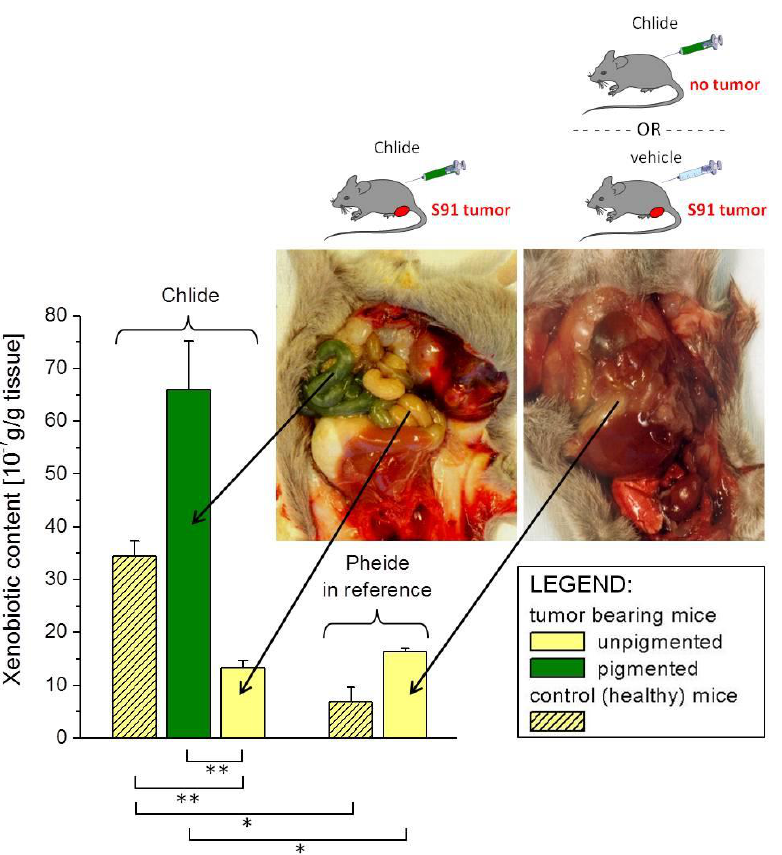
Figure 5. The levels of Chla derivatives in the intestines of DBA/2 mice: The test of Chlide content in the intestines of tumor-bearing and healthy control mice was performed 0.5 h after its i.p. administration. The levels of Pheide in reference mice (no compound administered) was also examined. The photographs in the inset were taken 0.5 h after Chlide was administered into the tumor-bearing mice (right) and the control mice (left). The bars represent the mean ( ± SE) level of Chlide in the intestine estimated via extraction with organic solvent. Chlide: three independent experiments, the number of animals N = 10; the reference: two independent experiments, N = 4. Statistical significance of the differences between groups: 1—** pigmented intestine vs. unpigmented intestine in tumor-bearing mice: p < 0.01; 2—** intestine in healthy mice treated with Chlide vs. unpigmented intestine in tumor-bearing mice treated with Chlide: p < 0.01; 3—* normal intestine in healthy mice treated with Chlide vs. normal intestine in reference mice: p < 0.05; 4—* pigmented intestine in tumor-bearing mice treated with Chlide vs. intestine in untreated tumor-bearing mice: p <